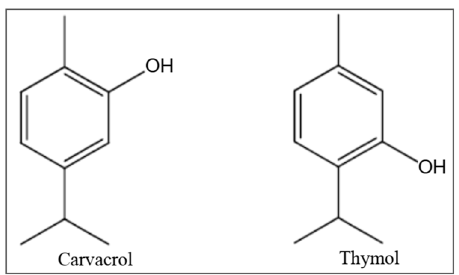
Figure 2: Chemical structures of the major compounds of the O. compactum EO.